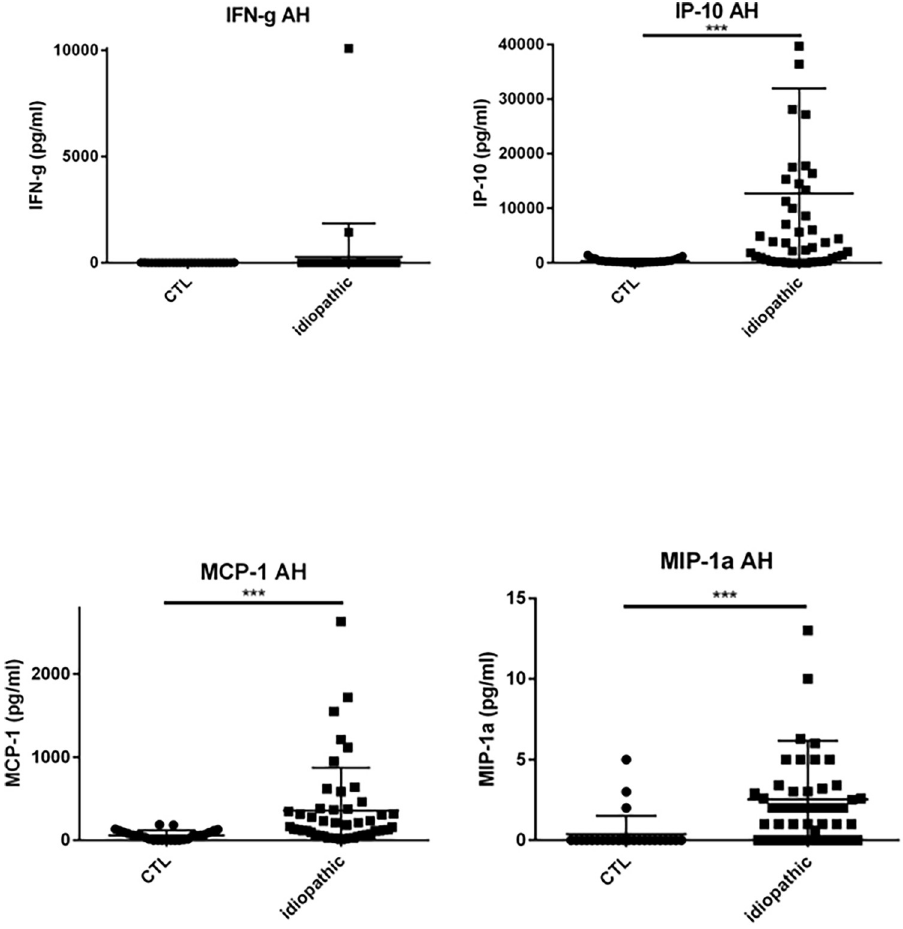
Fig 5. Dot plots of immune mediators: IFN- γ , IP-10, MCP-1, MIP-1 α , in aqueous humor of patients with idiopathic uveitis (N = 64) as compared with immune mediators in the aqueous humor of noninflammatory controls patients (cataract age-related) (N = 36). Note that few isolated patients with idiopathic uveitis had an immune mediator elevated. � = P < 0.05 ; �� = P < 0.01; ��� = P < 0.001.